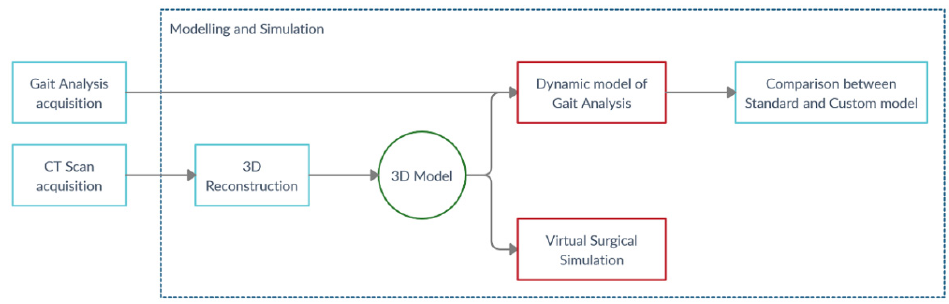
Figure 1. Methodology workflow.